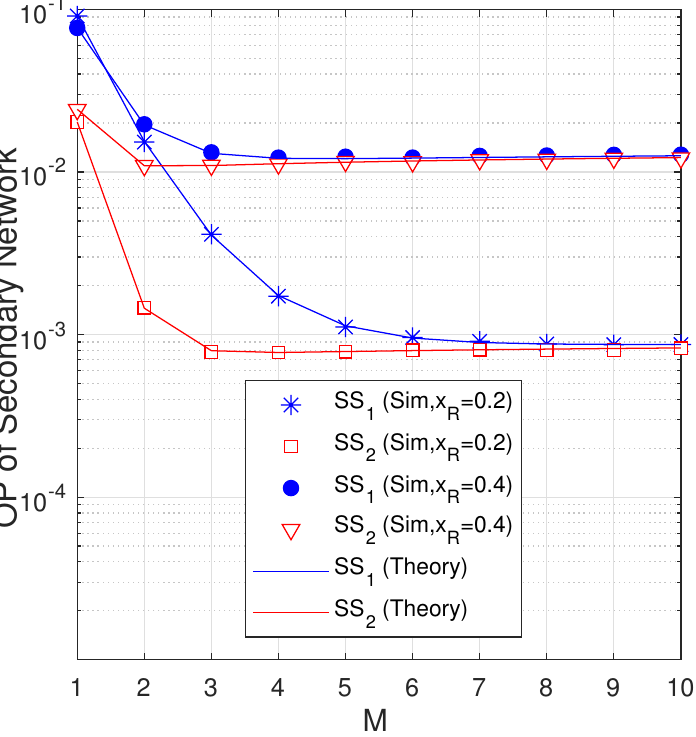
Figure 5. OP of the secondary sources as a function of M when P PT = 10